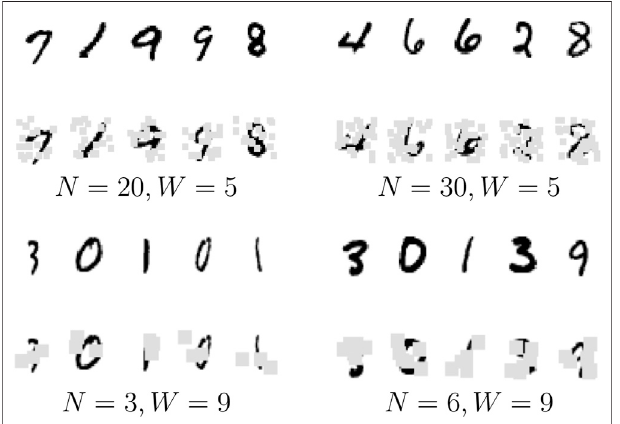
FIGURE 3 | Illustration of the training pattern of the proposed end-to- end learning scheme: We plot the evolution of the training loss (blue) for the training (-) and the test ( – ) datasets as a function of the number of training epochs for a FP-ConvAE architecture and the MNIST dataset with three randomlysampled9 × 9gaps.WealsoplottheevolutionoftheI-score(black). We increase the number of fi xed-point iterations from one to fi ve at epoch 12 and from fi ve to 10 at iteration 40 and from 10 to 15 at iteration